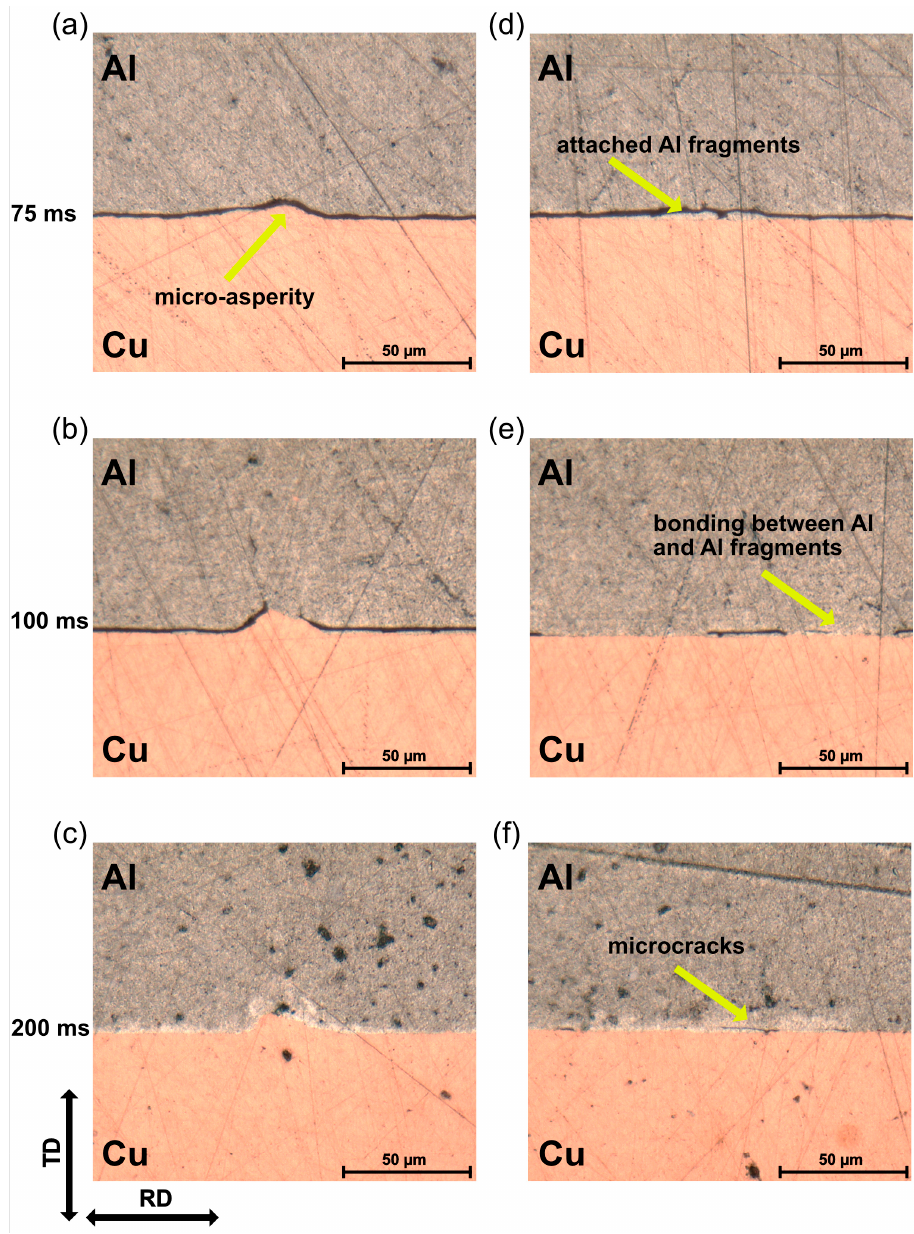
Figure 6. Optical micrographs of cross-sections at the weld interface: ( a – c ) microasperities; ( d – f ) locations with attached Al fragments.